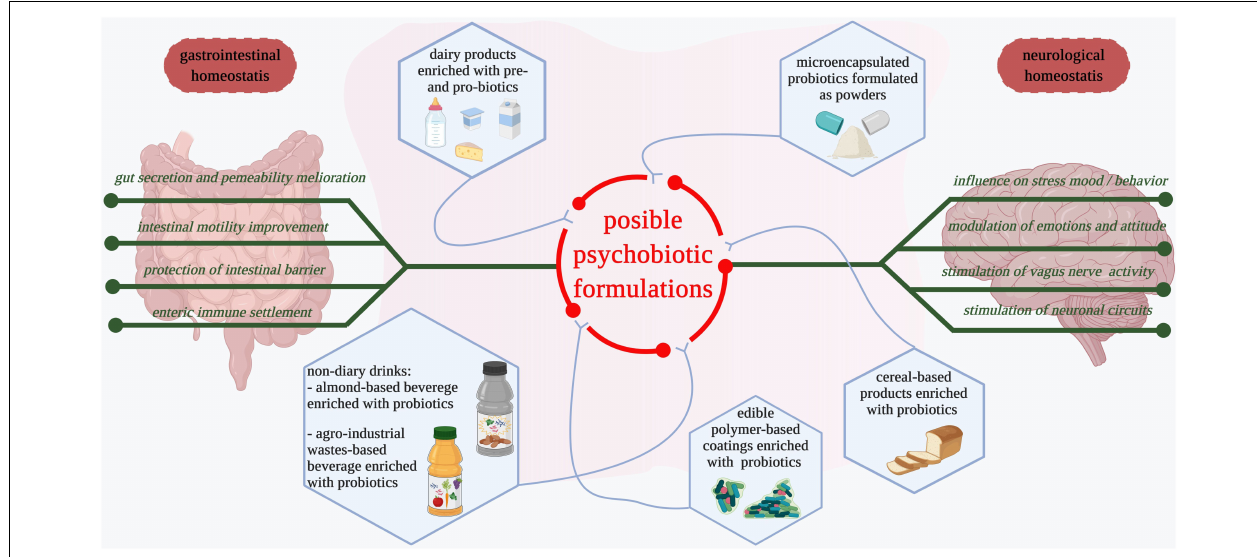
FIGURE 2 | Possible formulations of psychobiotics. Dairy products such as yogurt, milk, and cheese fortified with probiotic strains are among the most consumed food products that have a positive influence on the gastrointestinal tract and have possible beneficial implications in mental health (274). Microencapsulated probiotics and those formulated as powders are commercially available and administered as supplements after antibiotic treatments (275, 276). Cereal-based products are used as vehicles for probiotics delivery (274). Different edible biopolymer-based coatings with entrapped probiotics are developed to facilitate both probiotics consumption and reduction of non-degradable packaging materials (277, 278). Fruits, vegetables, and agro-industrial waste-derived beverages enriched with probiotics are developed for easier probiotic and bioactive compound delivery (264, 279). Edible products supplemented with probiotics maintain gastrointestinal homeostasis and influence neurological health. Deeper studies that consider the impact of probiotic food products as psychobiotics in the prevention and management of mental-associated diseases are needed.